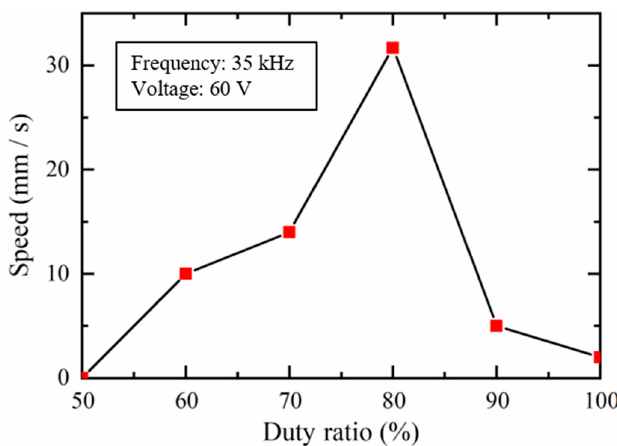
Figure 12. Driving characteristics of the slider 1 at different frequencies.